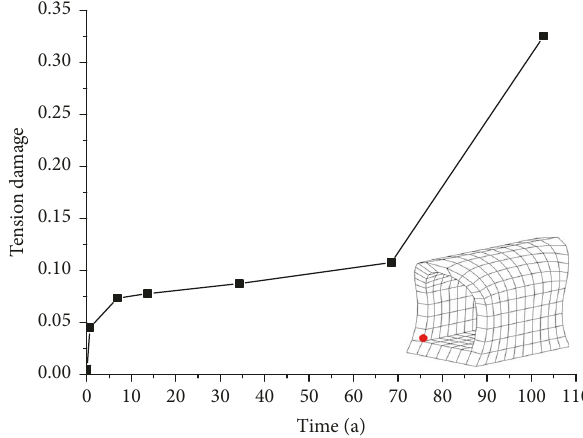
Figure 20: Maximum development curve of tensile damage of the transverse